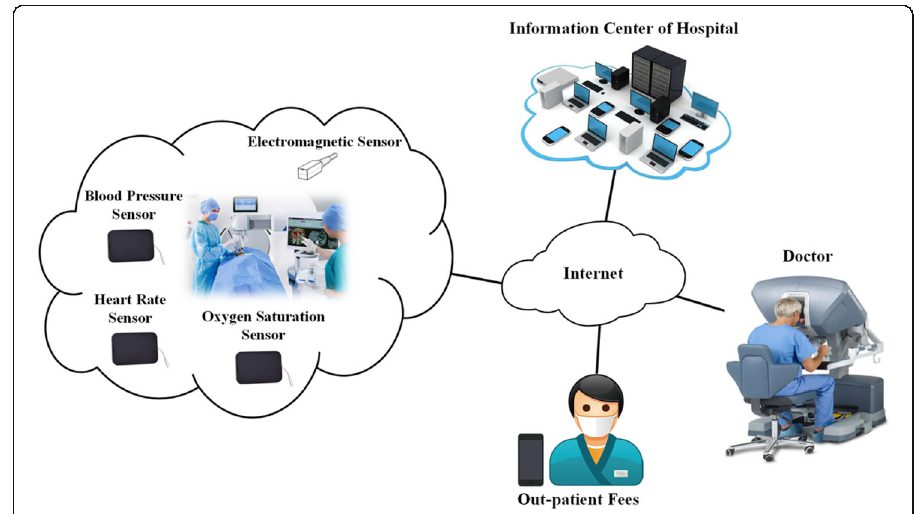
Fig. 1 Image-guided system based on